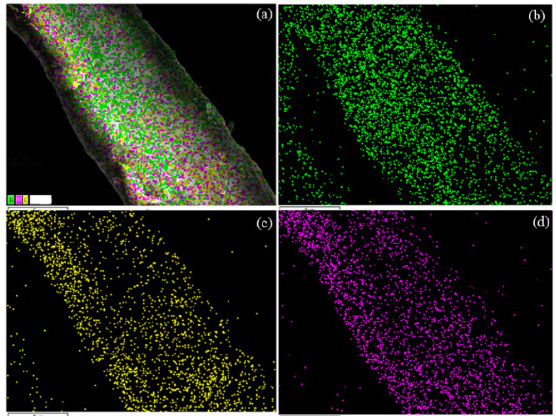
Figure 4. EDS (energy dispersive spectrometer) images of amino-capped TiO 2 NPs grafted cotton fabric: ( a ) cotton, ( b ) Ti, ( c ) O, ( d ) C.